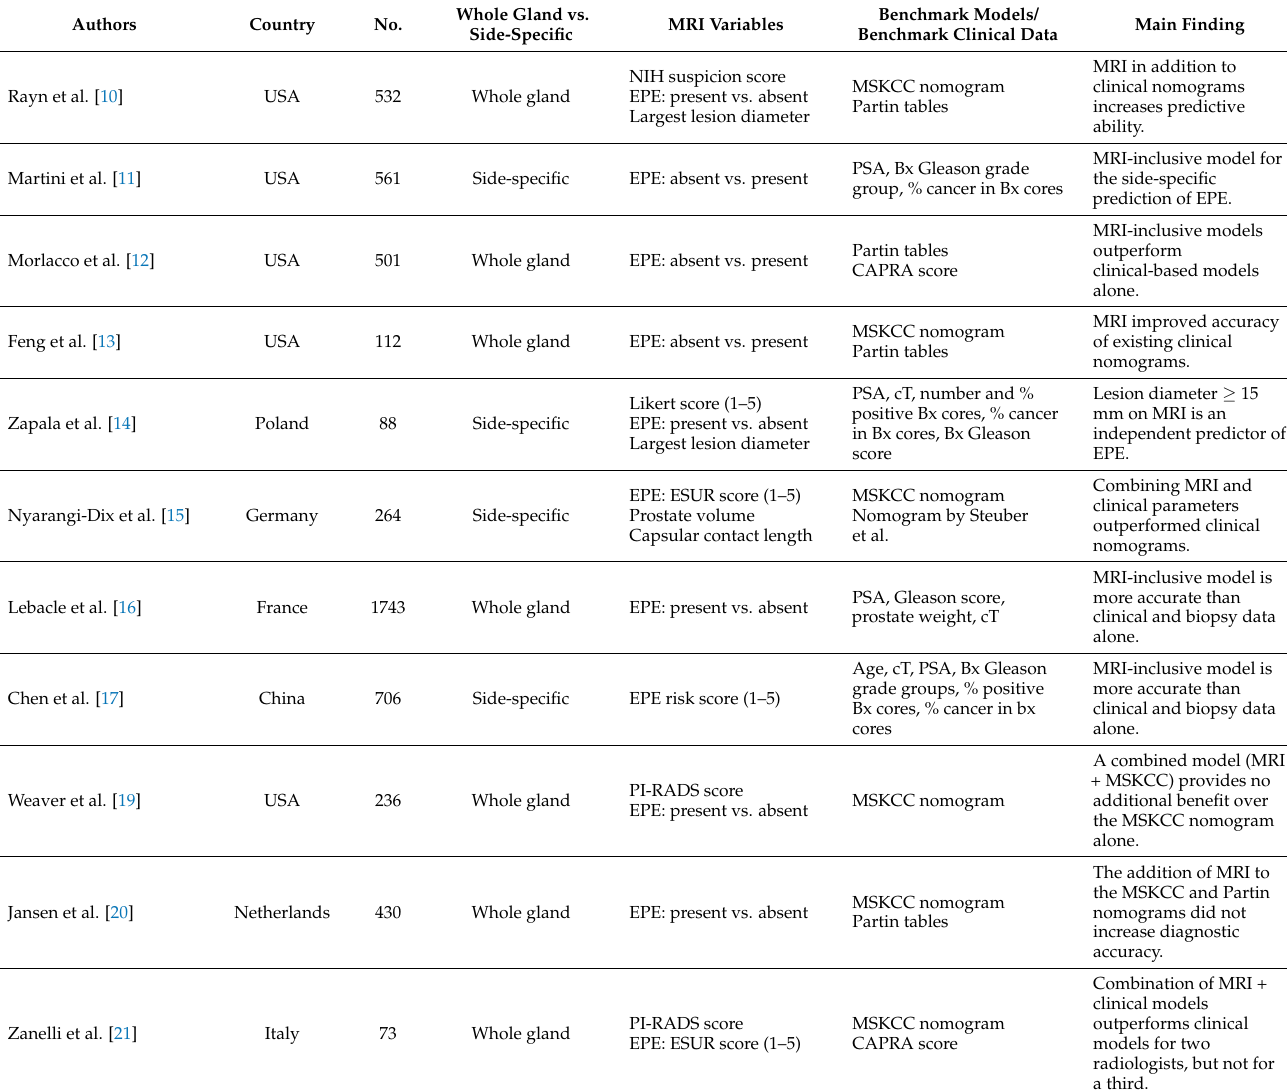
Table 1. Summary of previously published single-center studies investigating whether the addition of MRI information to established clinical/biopsy predictors of EPE could increase predictive